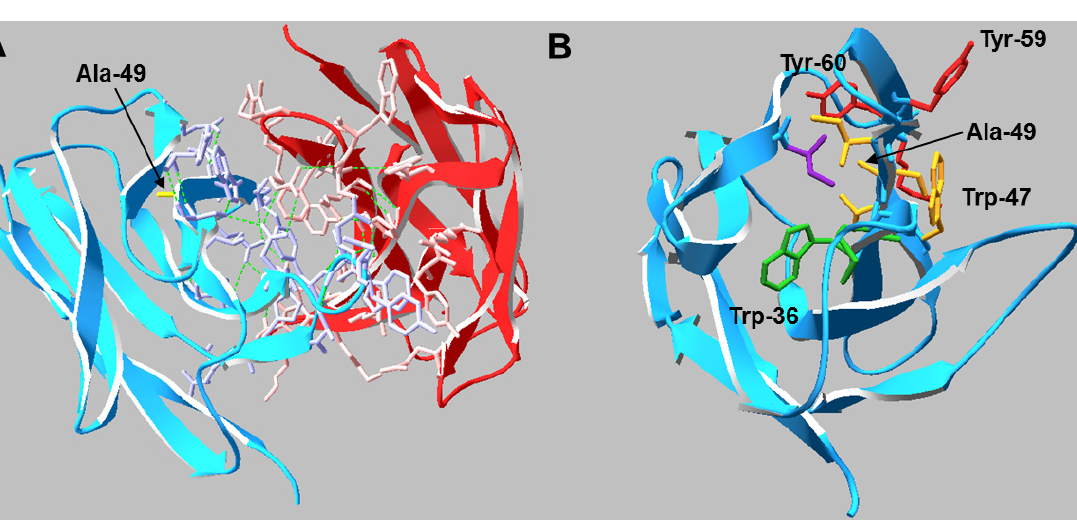
/V interactions in the Ala Fab domain. Residues Figure 1. ( A ) Crystal structure of the V H L that participate in the HC (blue) /LC (red) interface are shown in wire representation and the Ala-49 side chain is labeled (yellow). Hydrogen bonds are shown as green dashed lines. domain. Residues that may be conformationally influenced by ( B ) Top view of the V H Ala-49 (<5 Å distance) are shown in wire representation. Side chains sharing the same color reside on the same β